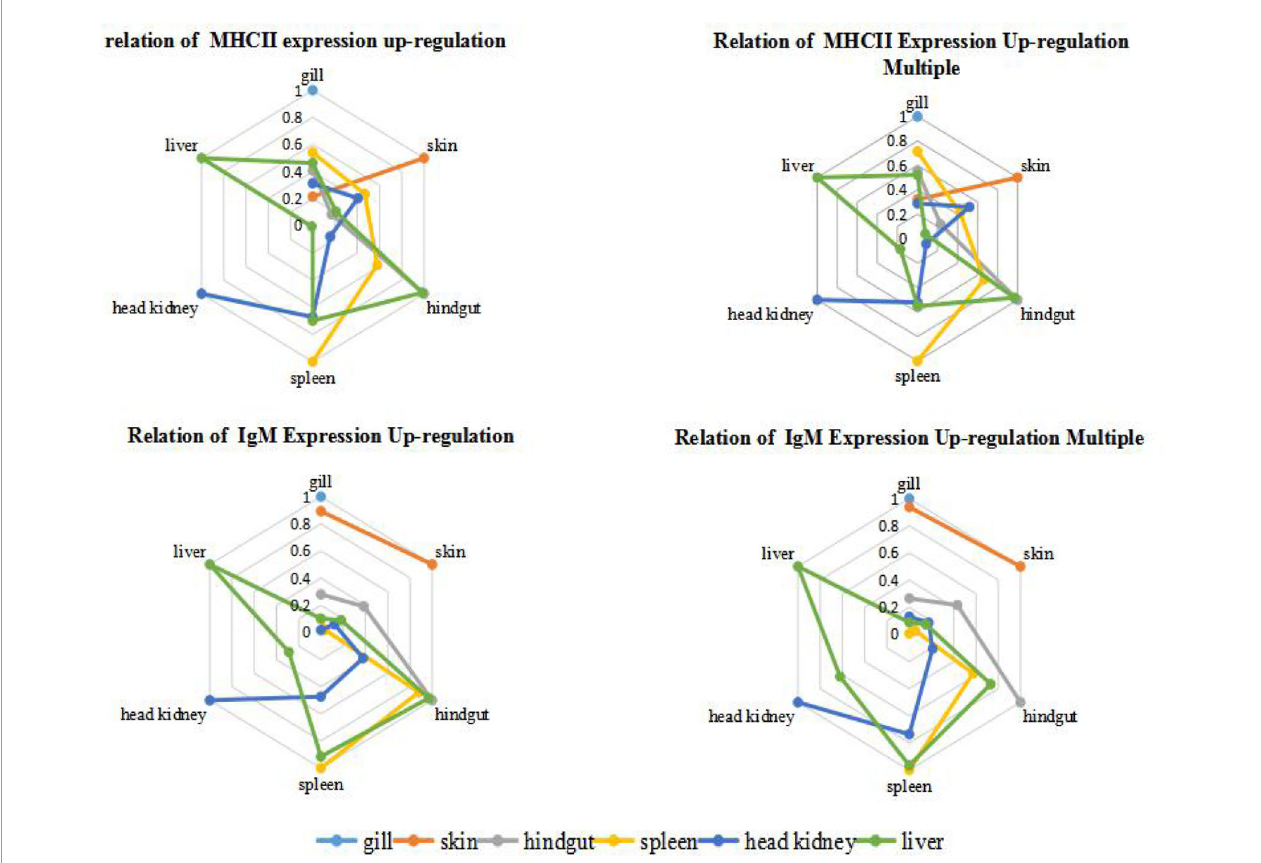
FIGURE 5 | Correlation analysis of grouper organs after immersion with inactivated V. harveyi vaccine. The relation of gene expression up-regulation was analyzed by the absolute value of r between the quantitative changes of gene expression in different organs after immunization; while the relation of gene expression up- regulation multiple was analyzed by the absolute r value of between the relative ratio of gene expression in different organs after immunization is analyzed, and this relative ratio is the ratio of gene expression in the same tissues between the immunized grouper and the control group.